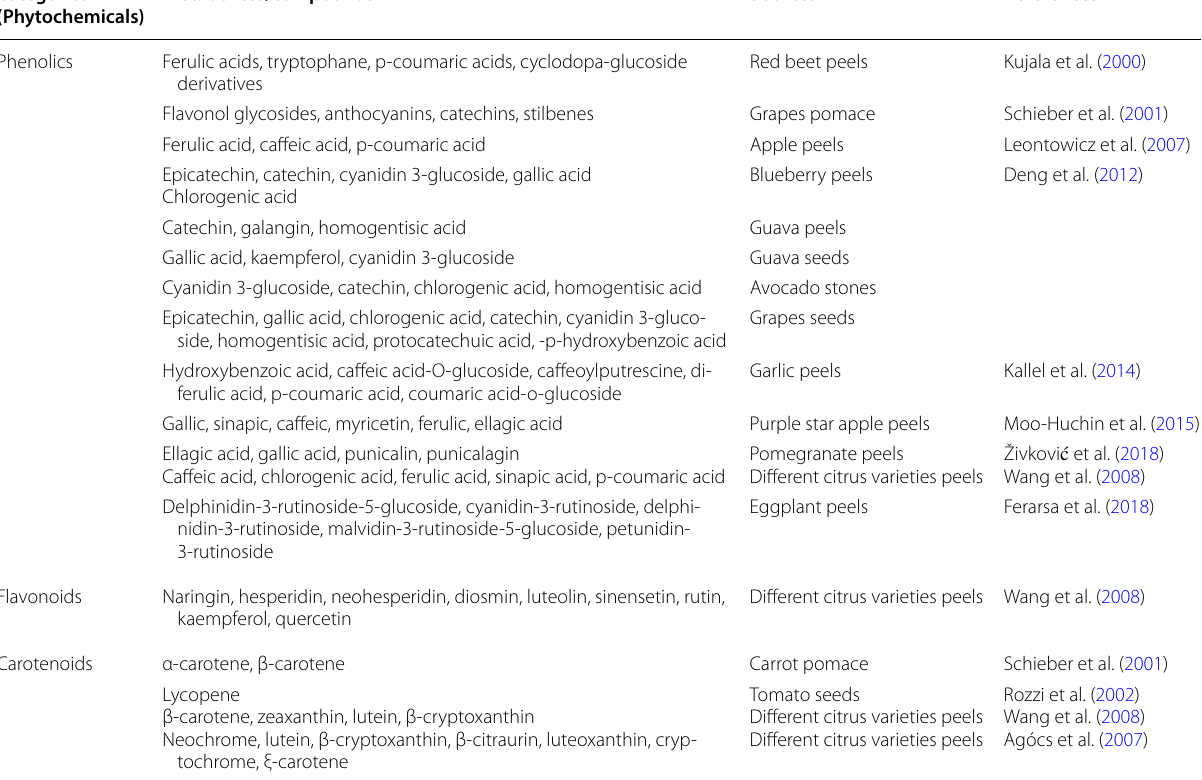
Table 1 Bioactive compounds of fruits and vegetables waste Categories (Phytochemicals)